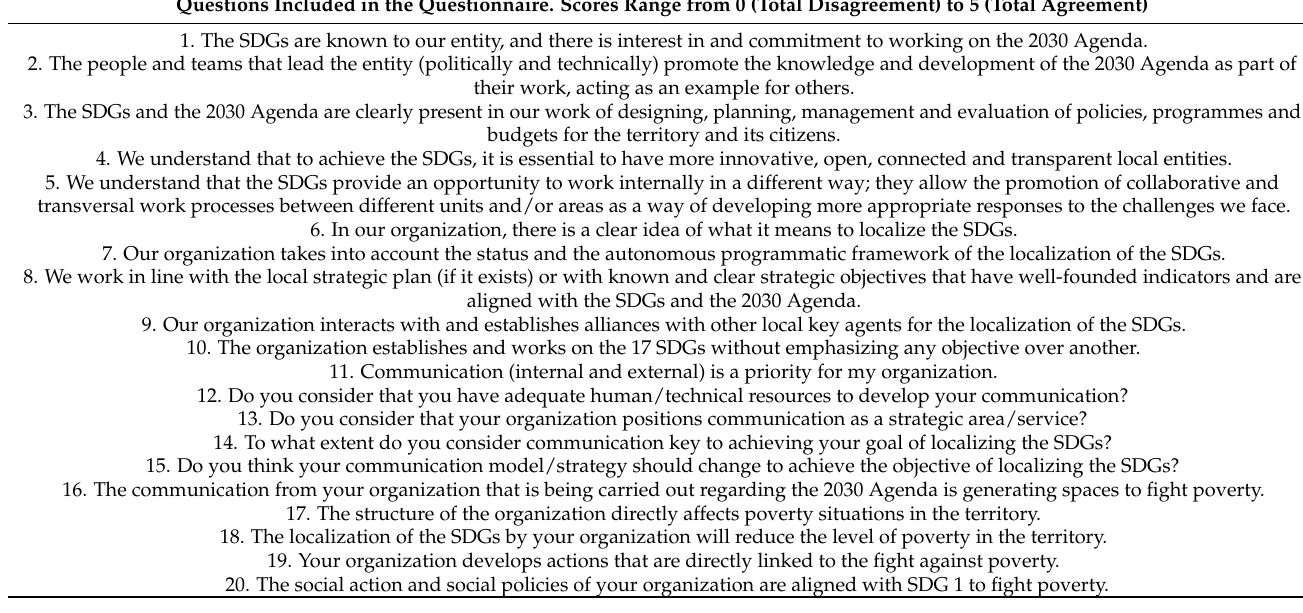
Table A1. Questions asked in the